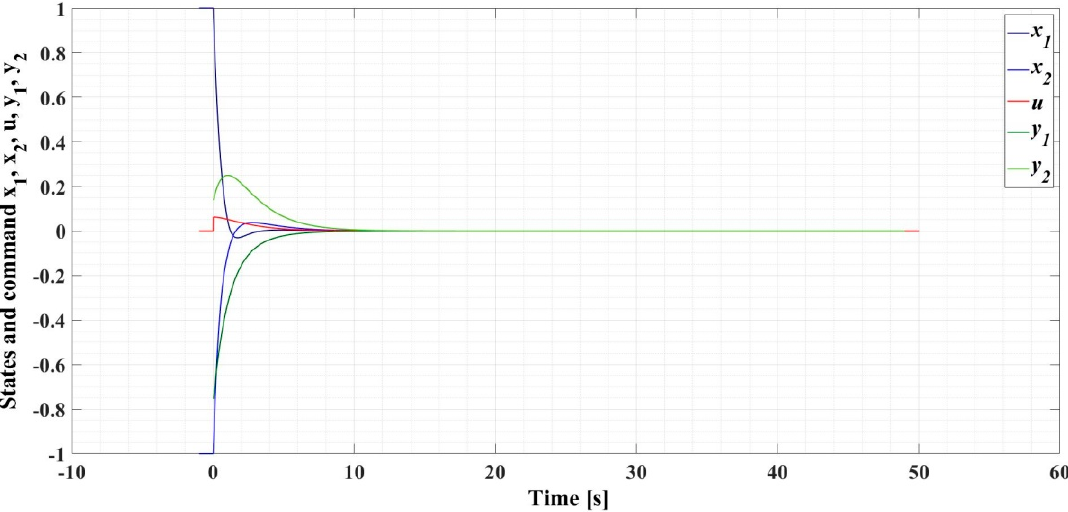
Figure 7. Evolution of the states without input saturation.